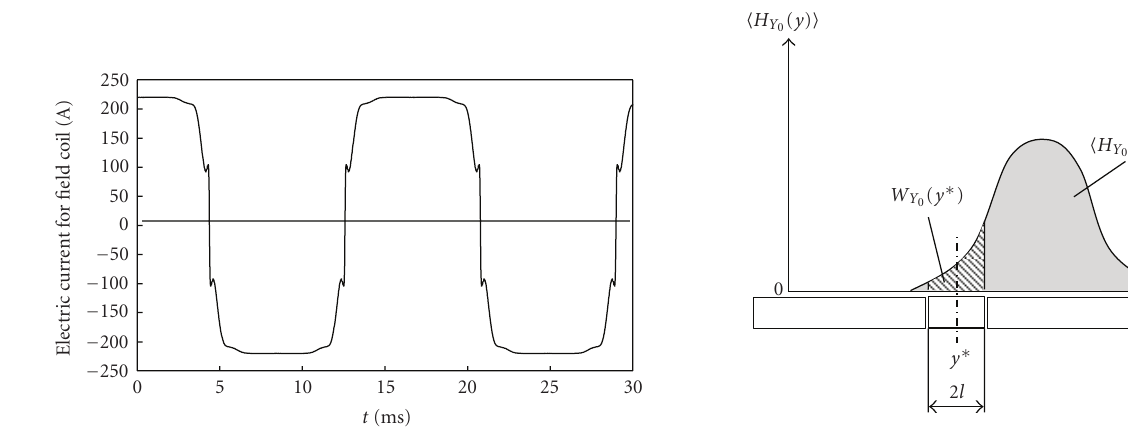
Figure 5: Coil current with sinusoidal waveform.